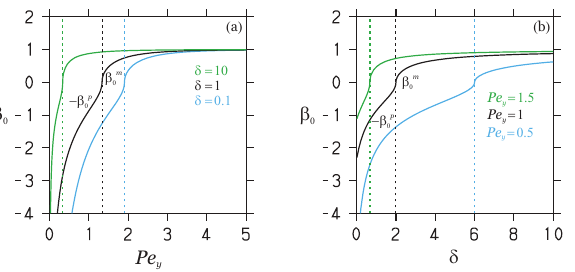
Figure 8. Eigenvalues β m Pe y ). The vertical lines separate β m